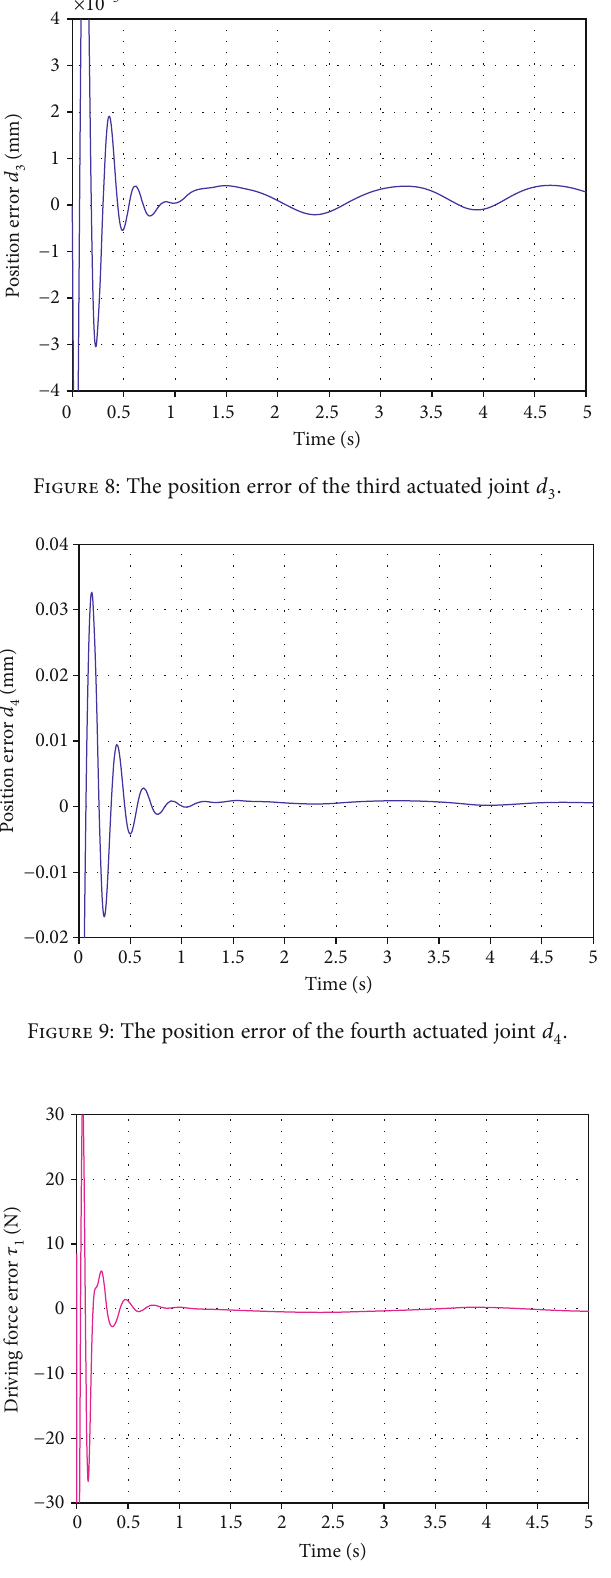
Figure 10: The driving force error of the fi rst actuated joint.